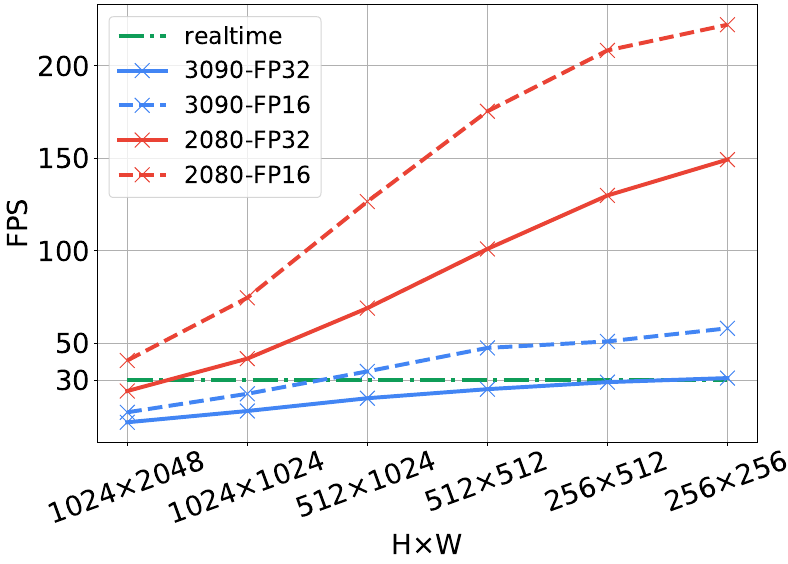
Figure 6. Inference speed of a three-level PSN-RN18 across different input resolutions for two graphics cards and two precisions. All configurations involve the same model after optimizing it with TensorRT. All datapoints are averaged over all images from Cityscapes val in order to account for the dependence of the post-processing time on scene